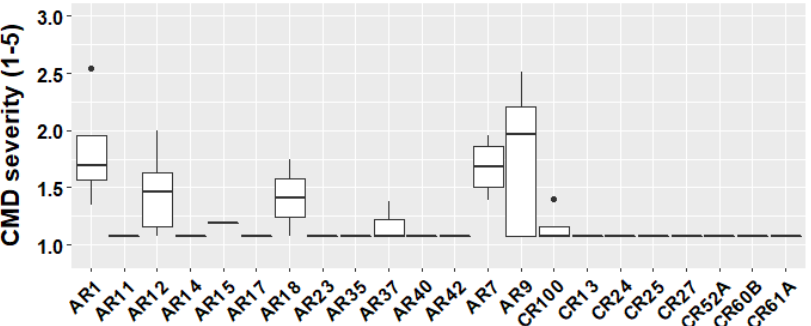
Figure 2. The CMD severity of 57 clones with the resistant allele T of S12_7926132 in full-sib families of CIAT102.In the five full-sib families, AR1, AR7, AR9, AR12, and AR18, the clones with the resistant allele T showed segregation in CMD resistance.